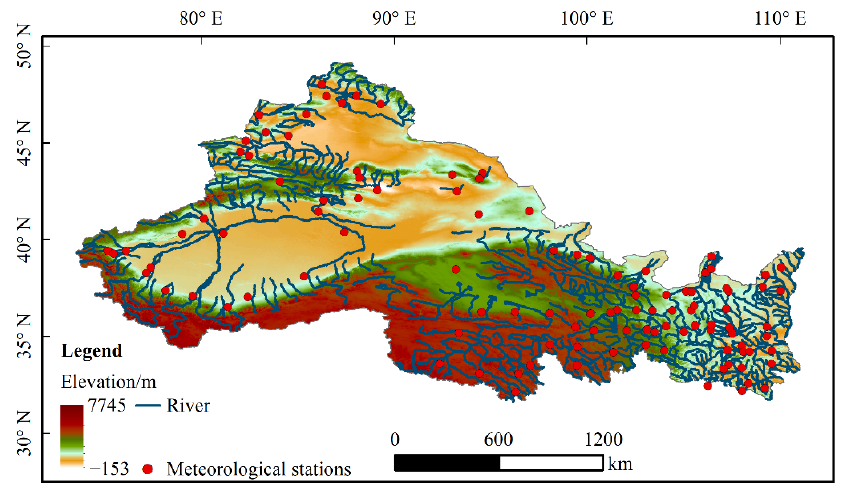
Figure 1. Distribution of meteorological stations in five provinces of Northwest China.